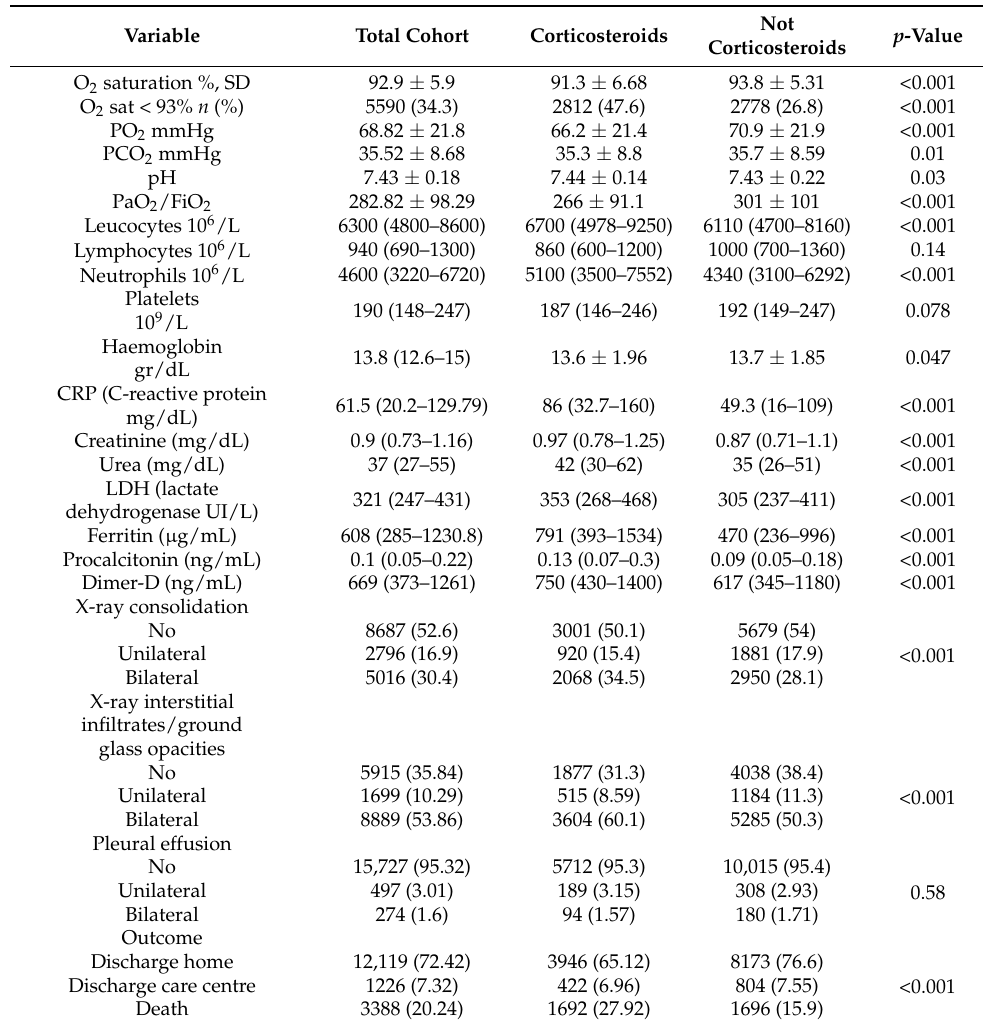
Table 2. Analytical, gasometric, and X-ray characteristics of the CT and non-CT